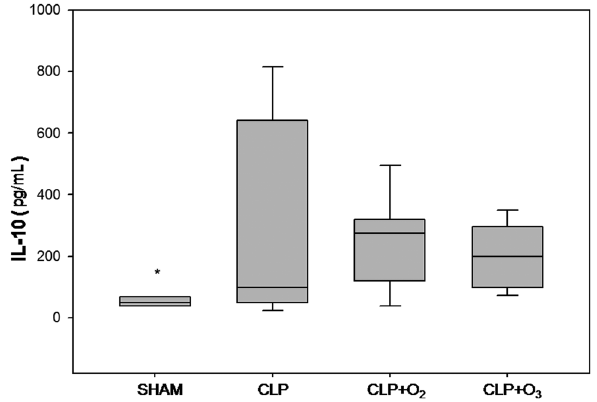
Figure 3 - Kruskal-Wallis test for IL-10 levels. The SHAM animals had lower levels of IL-10 than all other groups. There were no differences between groups CLP, CLP+O , and CLP+O ( p =0.855). The values are the median 2 3 (P25; P75) expressed as pg/ml. * Group SHAM vs. other groups ( P